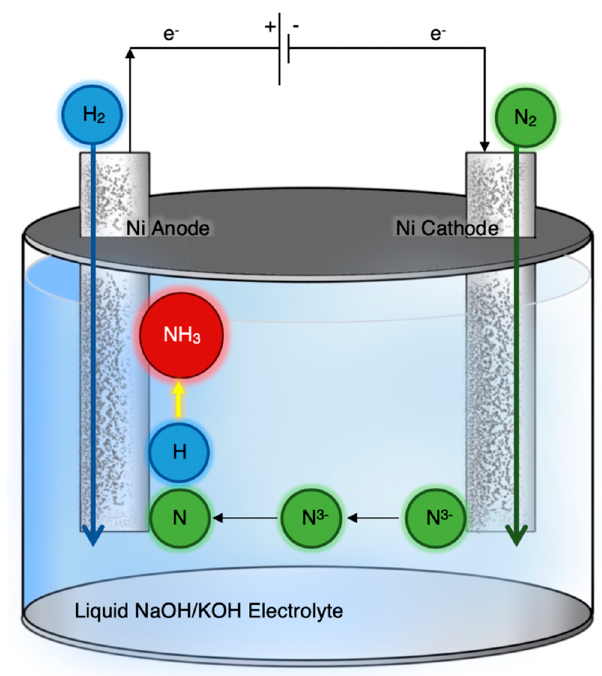
Figure 4. Schematic diagram of a molten salt (NaOH-KOH) cell where NH 3 is produced from the reaction of H 2 with N 3 − ions. Redrawn from [20].